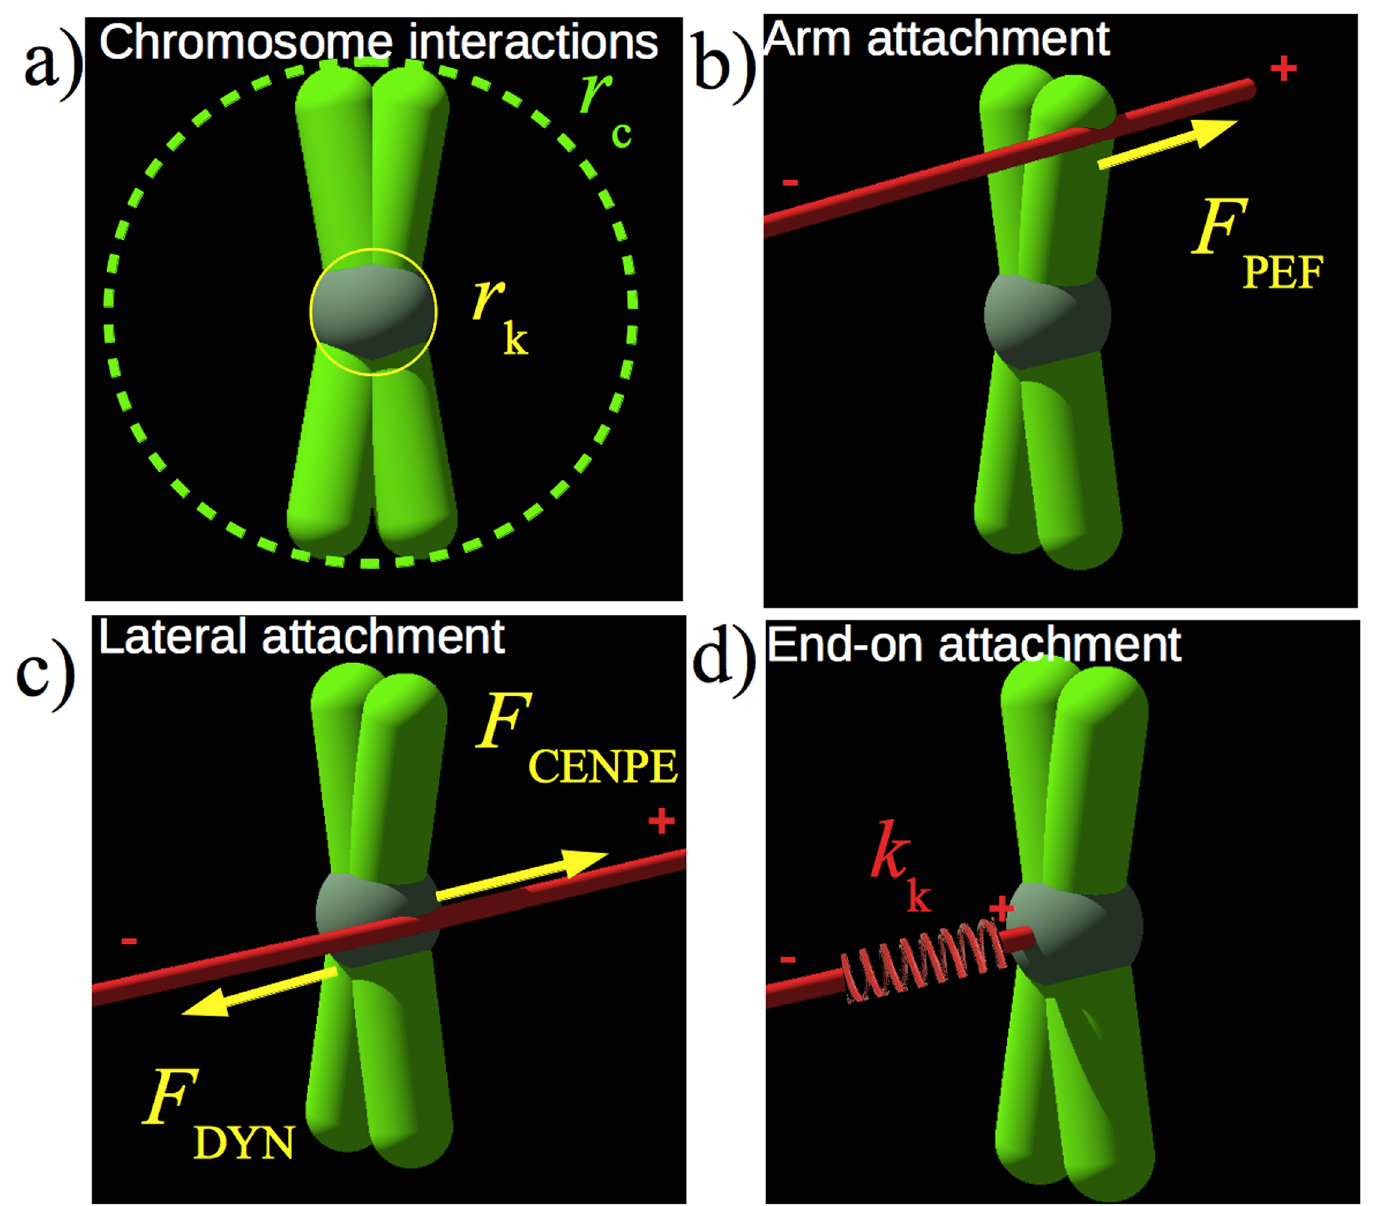
Fig 2. Schematic of the chromosome model and forces acting on it. a) The chromosome consists of freely rotating arms and of a sphere of radius r k , representing the kinetochore. In the model the arms is represented by a disk of radius r C , corresponding to the chromosome cross-section, and the kinetochore by a sphere of radius r k . Microtubules (red) interact with the chromosome and exert forces on it. b) A MT passing through a chromosome arm, adds a force F PEF in the direction of the plus-end of the MT. c) Lateral attachments add constant forces originating from groups of motor proteins at the kinetochore. Which group, dynein or CENP-E is active, is determined by the simulation and described in detail in the main body of the text. d) MT tips can form end-on attachments with the kinetochore, which is represented by a harmonic spring with stiffness k k and zero rest length.